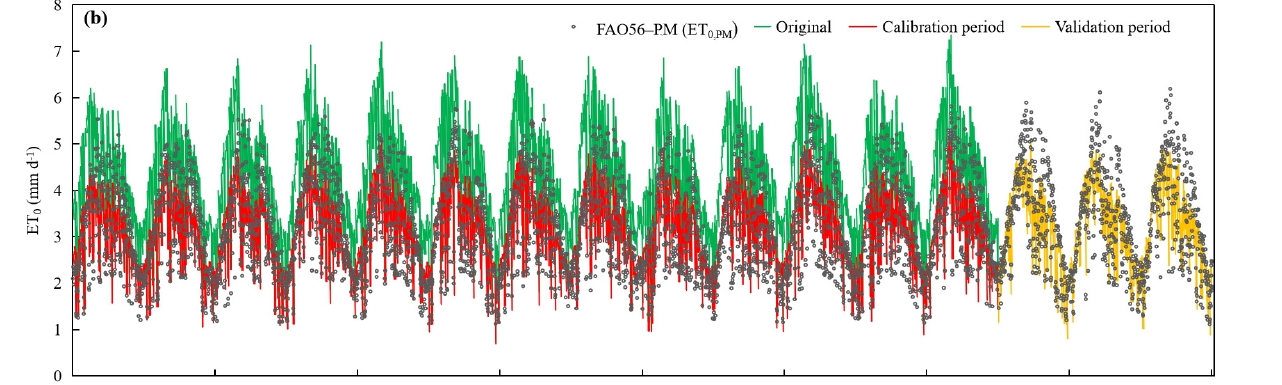
Figure 4. ( a , b ) The ET 0 calibration and validation of the HS model. Table 3. Statistical indices of ET 0 calculated by the HS model.